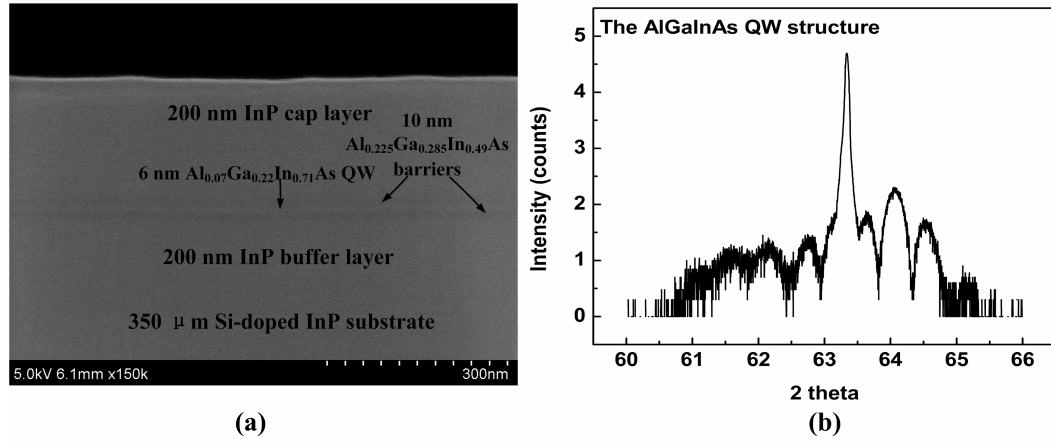
Figure 1. ( a ) Cross-sectional SEM image of the AlGaInAs quantum well (QW) structure. ( b ) Intensity (counts)-2 θ scans of HR-XRD